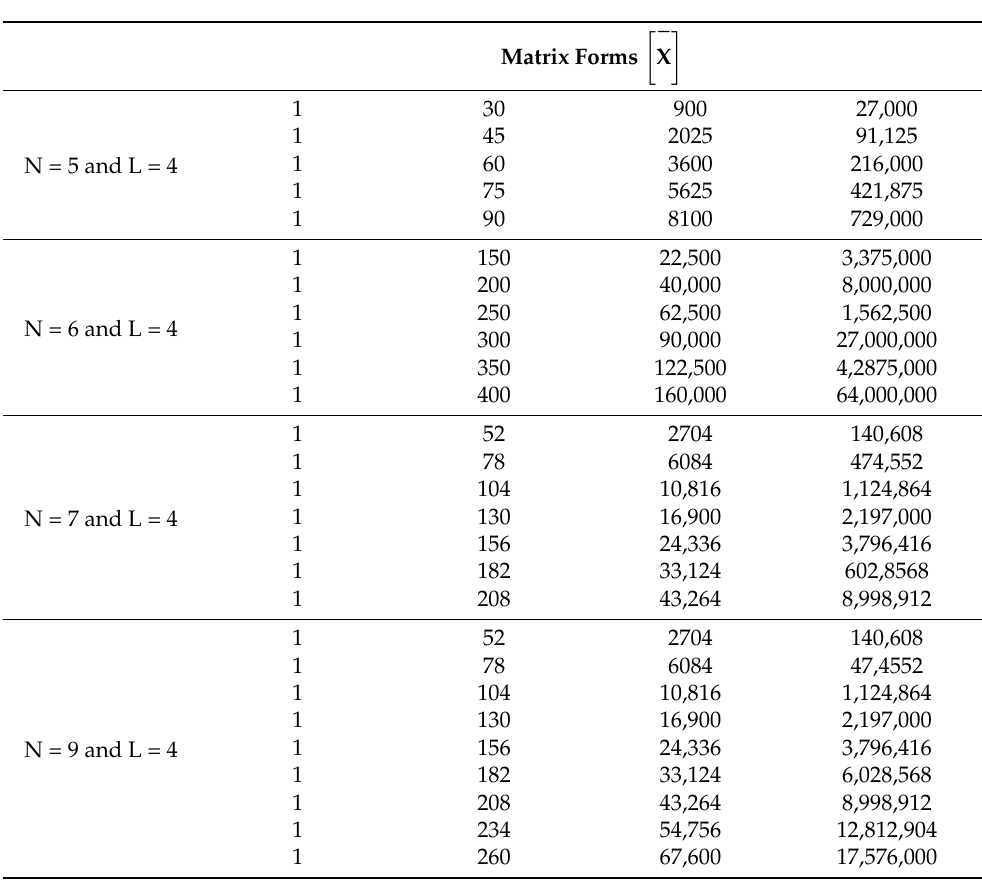
Table 19. Matrix forms L =